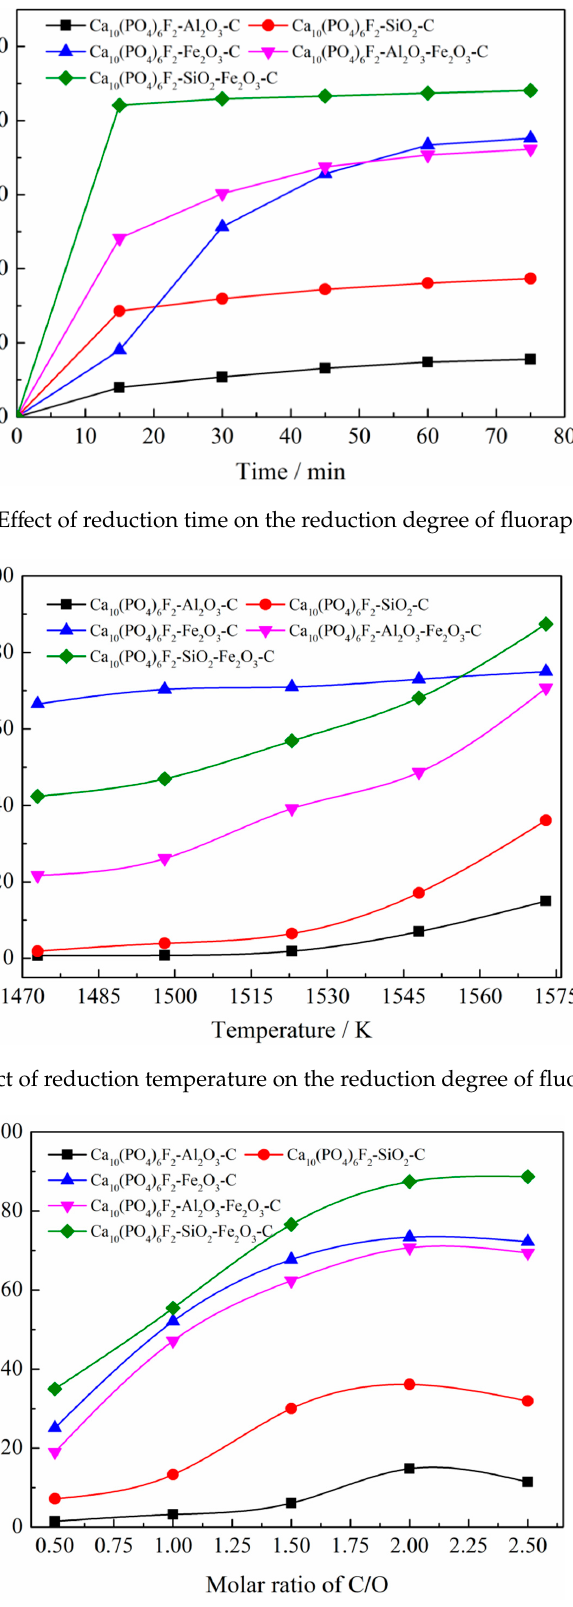
Figure 5. Effect of C/O molar ratio on the reduction degree of fluorapatite. Figure 5. E ff ect of C / O molar ratio on the reduction degree of